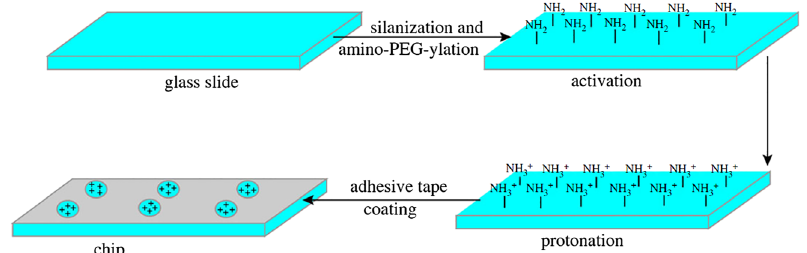
Figure 17: Preparation schematic of portable chip for bacteria-capture and detection